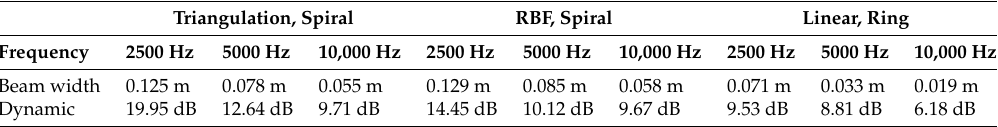
Figure 3. Octave band source maps for 2.5, 5 and 10 kHz obtained with the spiral array and no virtual rotation of the microphones. Table 3. Comparison of array geometry and interpolation method regarding side lobe dynamic and beam width of the main lobe. All results are calculated for source